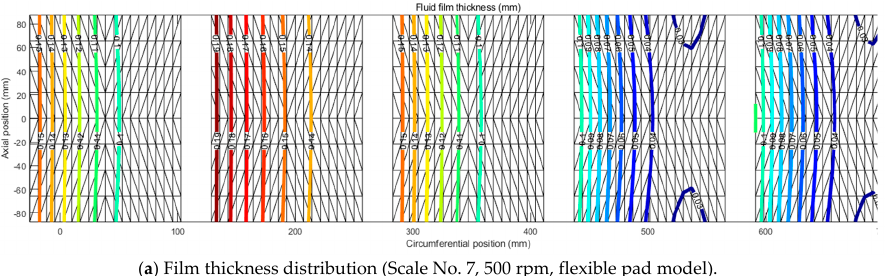
Figure 9. Nondimensionalized thermal deformation properties.